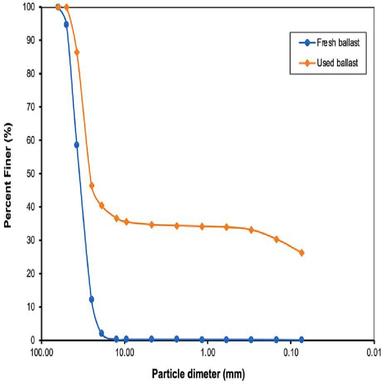
Gradation properties of fresh and used ballast material.